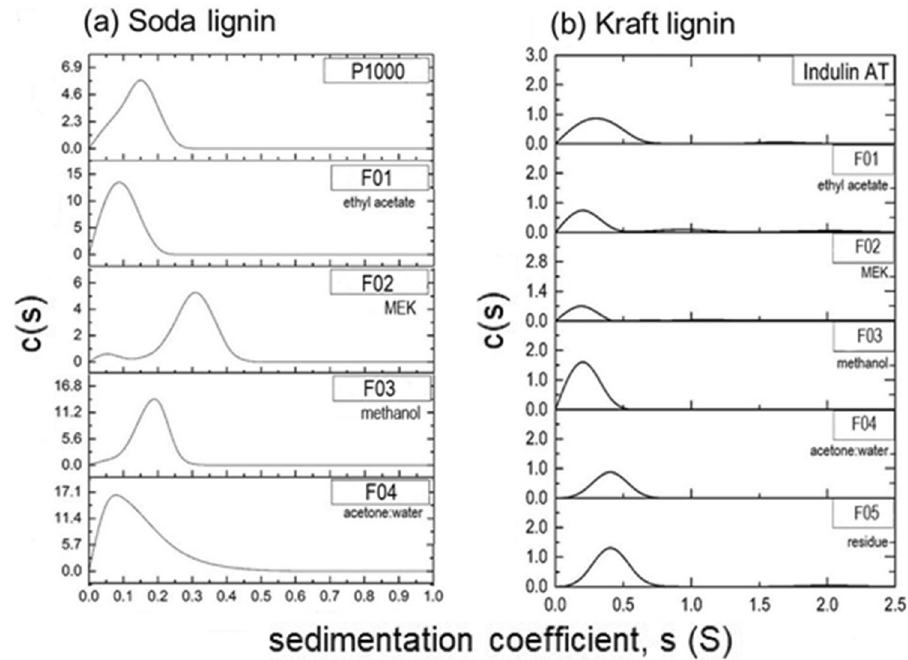
Figure 2. Sedimentation coefficient concentration distribution, c( s ) vs s , profiles for ( a ) soda (P1000) and ( b ) Kraft (Indulin AT) lignins and their fractions derived from a four-step solvent extraction comprising ethyl acetate (F01), methyl ethyl ketone (MEK) (F02), methanol (F03) and acetone:water (4:1) (F04). Data for Kraft lignin residue following extraction was also obtained (F05). Dried samples were dissolved in DMSO:water (9:1) prior to SV experiments at 20.0 °C at loading concentrations of 0.2 mg mL −1 and a rotor speed of 49,000 rpm, as described in “Methods”